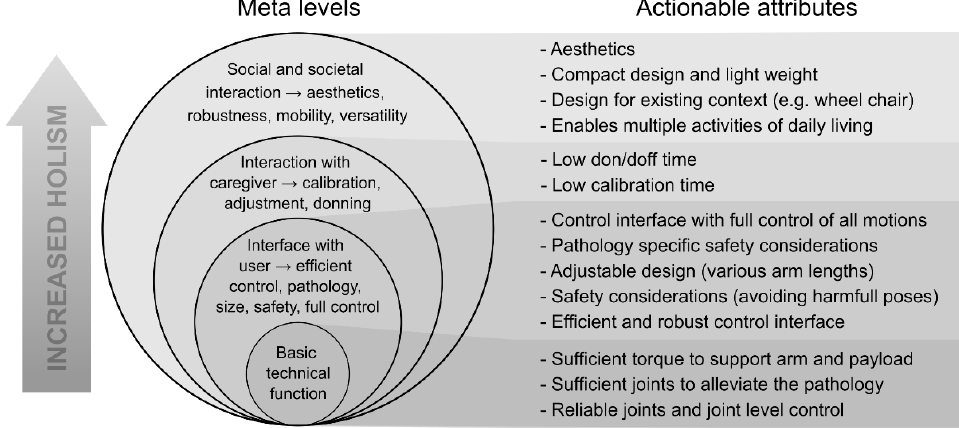
Figure 1. Onion model representing the meta-levels of design considerations for assistive exoskeleton design. To the right, attributes of each level are specified into actionable attributes. Note: the figure should be read bottom up.